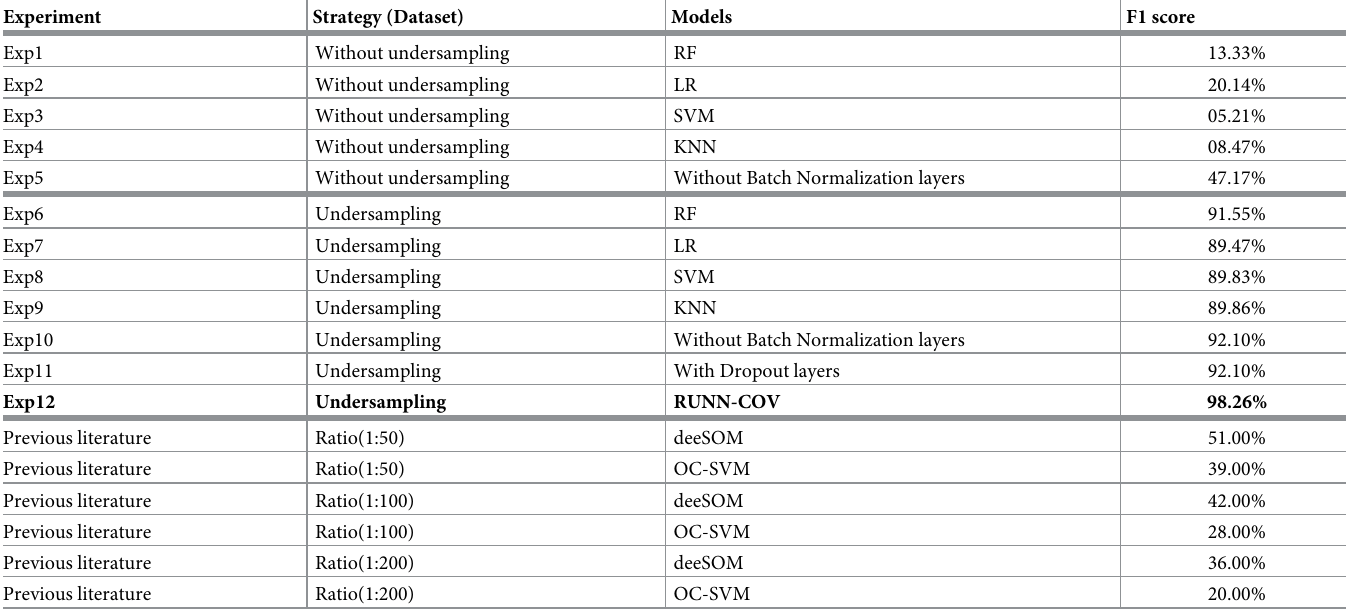
Table 5. Number of experiments, sampling strategy, variation of models and layers, and performance against previous and proposed approaches. Experiment